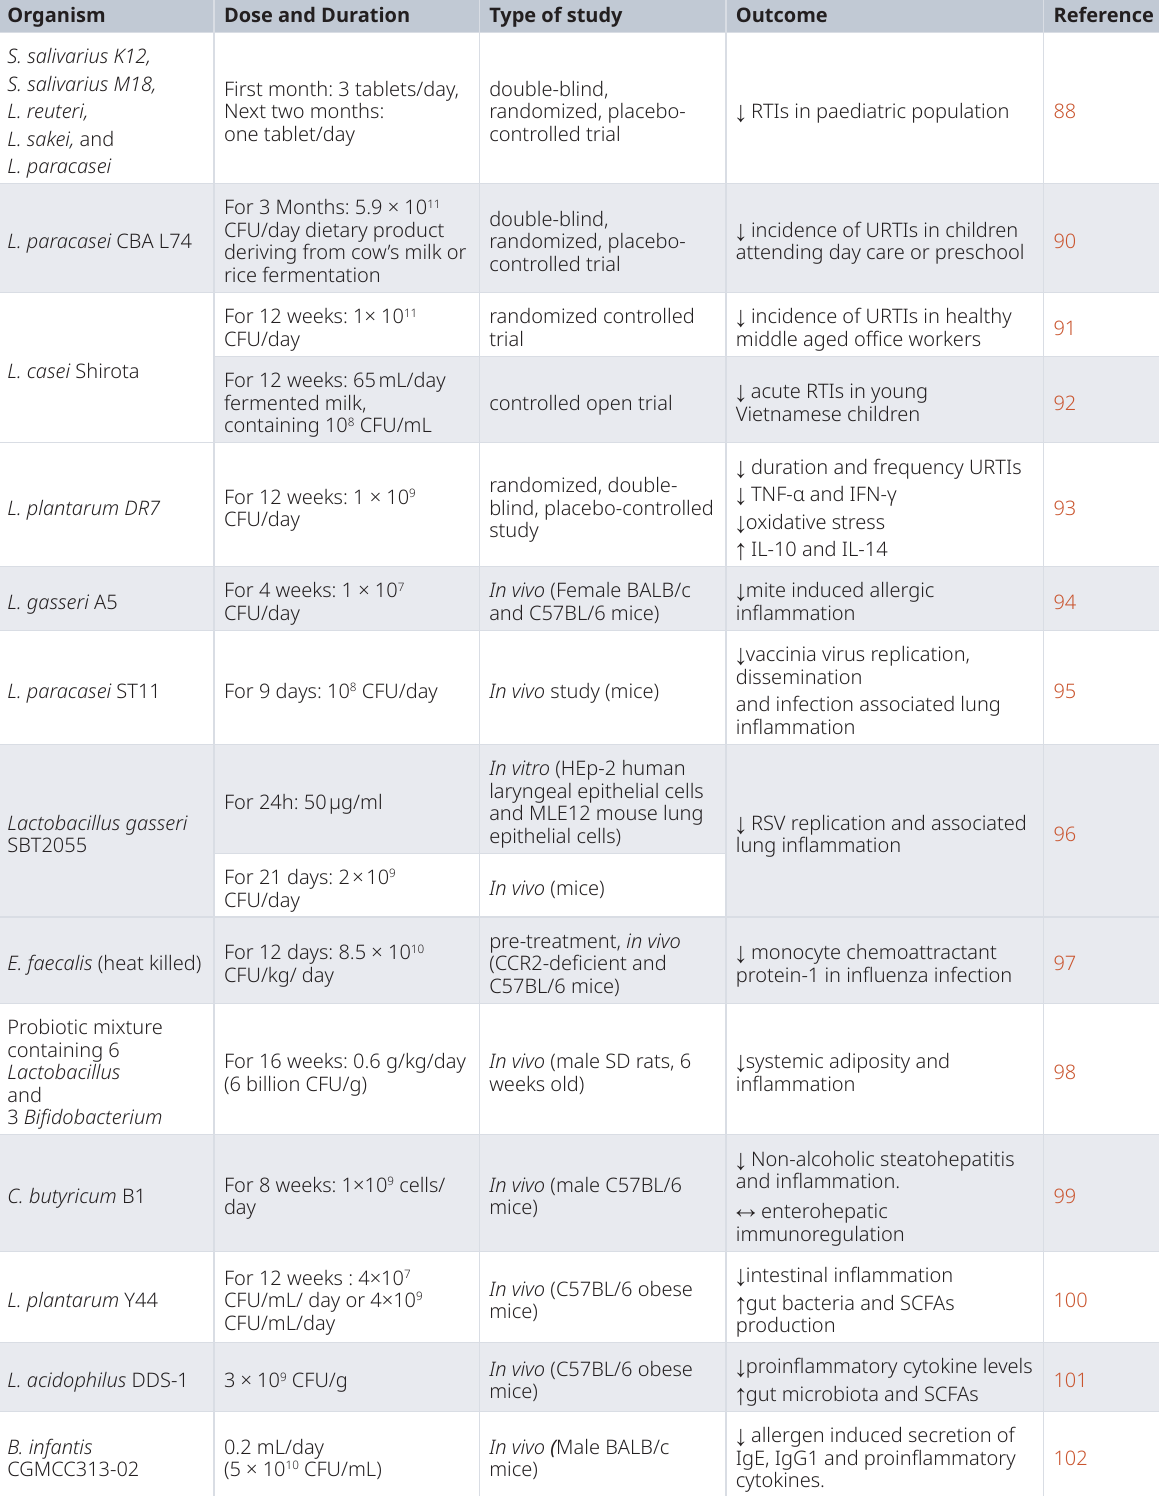
Table 1. Ameliorative role of probiotics in suppressing respiratory tract infections and hyperinflammation.